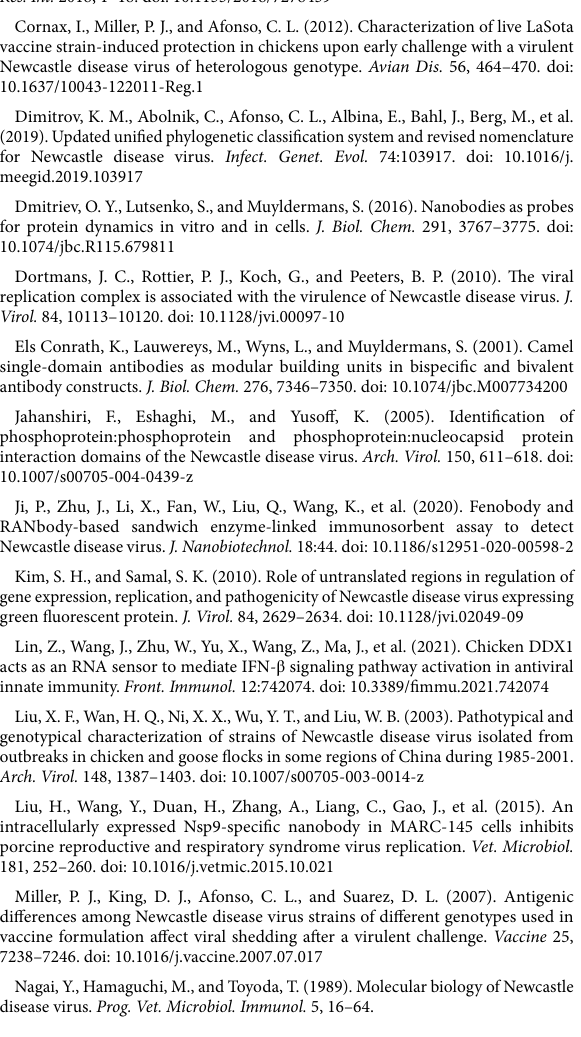
SUPPLEMENTARY FIGURE S1 Schematic diagram of lentivirus vector PLVX-IRES-ZSgreen1.